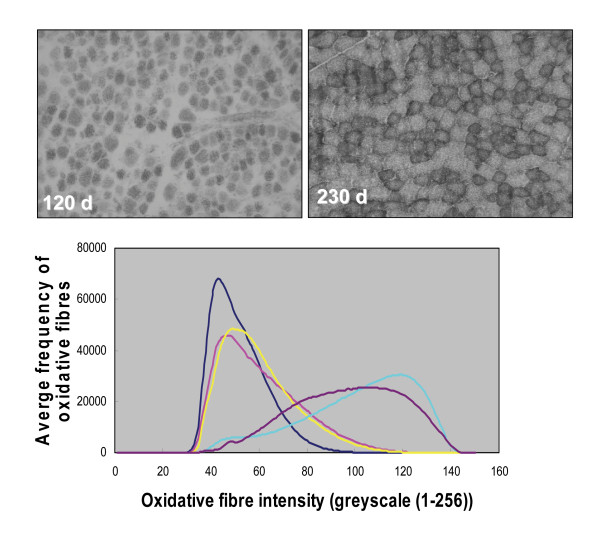
Muscle fibre type histochemistry showing the frequency of oxidative fibres in samples across the developmental period. NADH-Tr histochemistry was used to identify oxidative fibres in sections of LD muscles from animals sampled at 80, 100, 120, 150 and 230 days of development (n = 3 at each developmental stage). (a) Examples of histochemical staining patterns in a 120 d fetal sample (left panel) and a sample taken at 230 d of development (young immature lamb) (right panel). (b) A series of random grey-scale images was collected from each section and converted to pixel grayscale intensity values. The average frequency across the images from each sample was calculated and the mean for the three animals at each developmental time was then graphed. Greater pixel intensity corresponded with increased staining and therefore higher oxidative activity. The developmental times are differentially colored: 80 d (black); 120 d (yellow); 100 d (red); 150 d (blue), and; 230 d (purple).